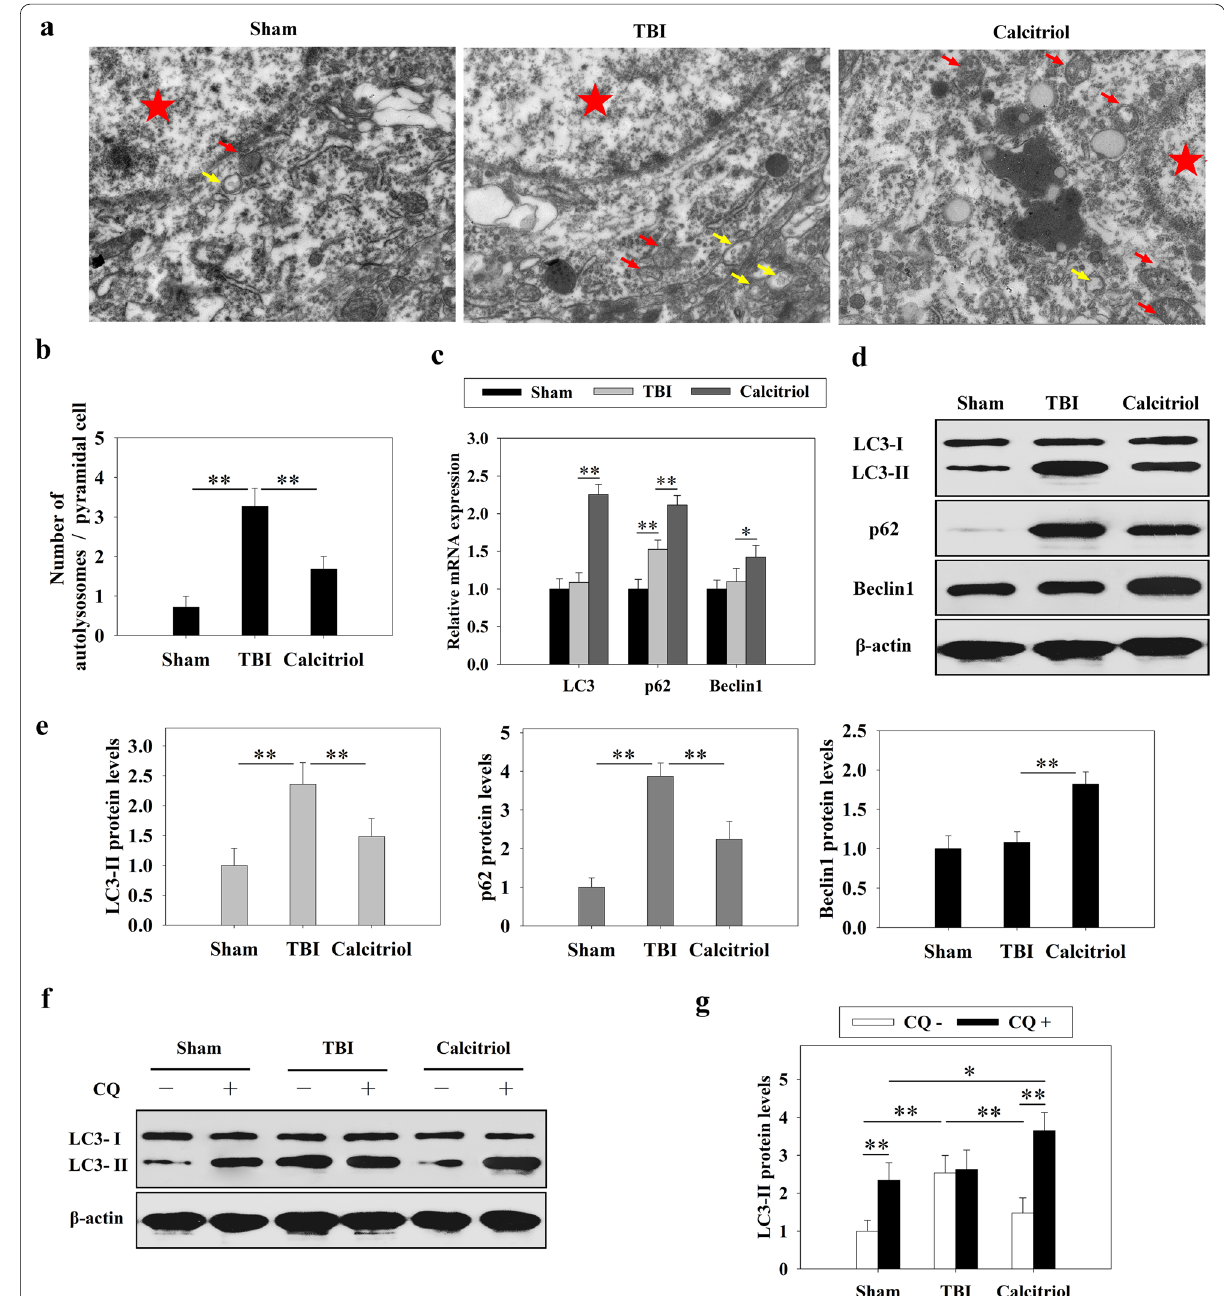
Fig. 3 Calcitriol (0.5 µg/kg) treatment attenuated TBI-induced autophagic dysfunction. a Representative transmission electron microscopy (TEM) images of three groups. Red pentagram denotes representative nucleus, yellow arrows denote representative autophagosomes and red arrows denote representative autolysosomes. b Statistical graphs of number of autophagosomes and autolysosomes per cell. c The effects of calcitriol treatment and TBI on the mRNA expression levels of autophagic markers. d Representative images of Western blots of autophagic markers. e Graphs of LC3-II, p62, and beclin 1 protein expression levels. f , g Chloroquine (CQ) was used to evaluate the effects of calcitriol treatment and TBI on autophagic flux. Data are presented as means SEM ( n 5). * P < 0.05 and ** P < 0.01 versus the indicated groups. (Sham: sham-operated group; TBI: ± = TBI model group; Calcitriol: TBI calcitriol treatment +